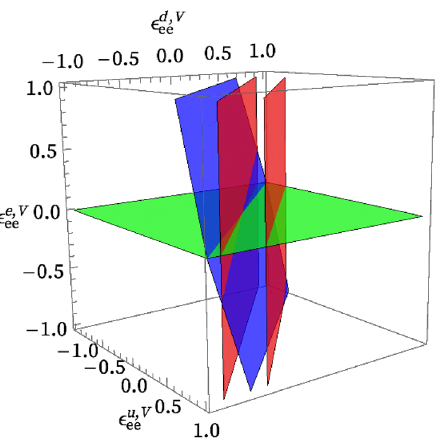
Figure 1 . The overlapping plane solutions for CE (cid:23) NS (red), E (cid:23) ES (green), and oscillation (blue) experiments for a single (cid:13)avor index ee . In this scenario, the intersection point where all three sets of solutions hold is at the origin